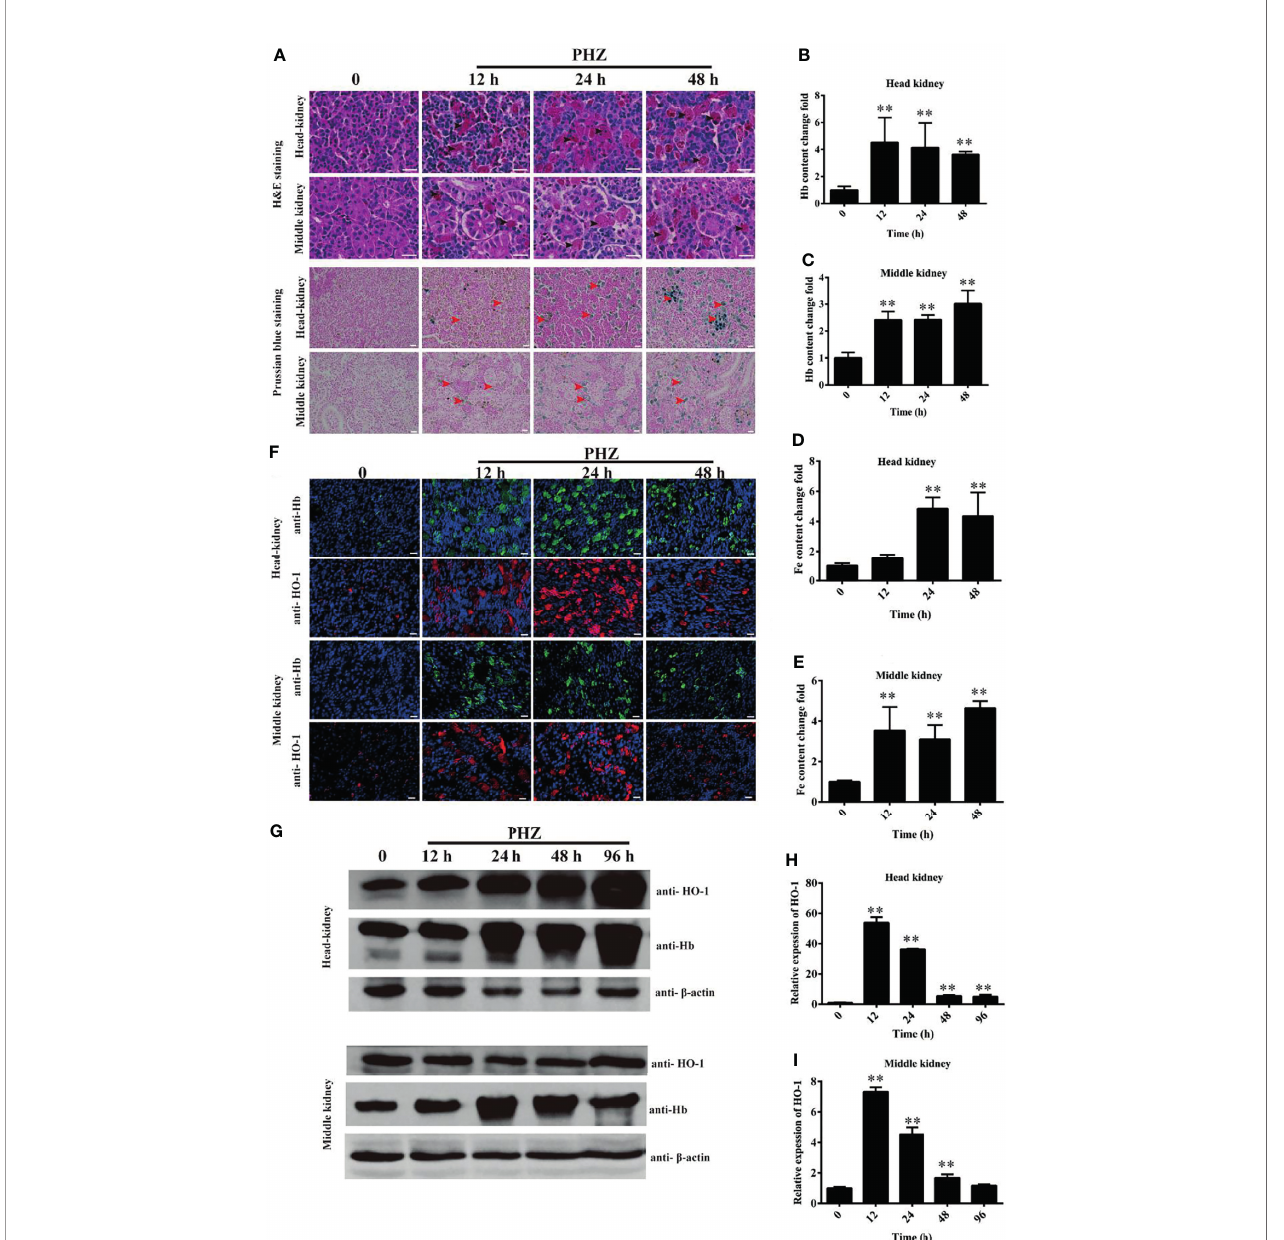
FIGURE 2 | Hemolysis increased the iron deposition and injured the tissues. (A) Hematoxylin – eosin (H&E)- and Prussian blue-stained head and middle kidney at 12, 24, and 48 h after phenylhydrazine (PHZ) injection. The black arrow denotes several leukocyte-like cells aggregating together to phagocytose the excess hemoglobin, while the red arrow represents ion accumulation in the head and middle kidney. Scale bar , 20 m m. (B, C) Contents of hemoglobin in the head (B) and middle (C) kidney after PHZ injection at 12, 24, and 48 h (D, E) Detection of iron accumulation in the head (D) and middle (E) kidney after PHZ injection at 12, 24, and 48 h (F) Accumulation of hemoglobin and heme oxygenase-1 (HO-1) in the head and middle kidney determined by immuno fl uorescence assay (IFA) after PHZ injection at 12, 24, and 48 h Scale bar , 20 m m. (G) Western blotting (WB) was used to analyze the accumulation of hemoglobin and HO-1 in the head and middle kidney after PHZ injection at 12, 24, 48, and 96h (H, I) mRNA transcript levels in the head and middle kidney analyzed by qRT-PCR after PHZ injection at 12, 24, 48, and 96 h ** p < 0.01 (Student ’ s t -test). Data represent the mean ± SD of three independent